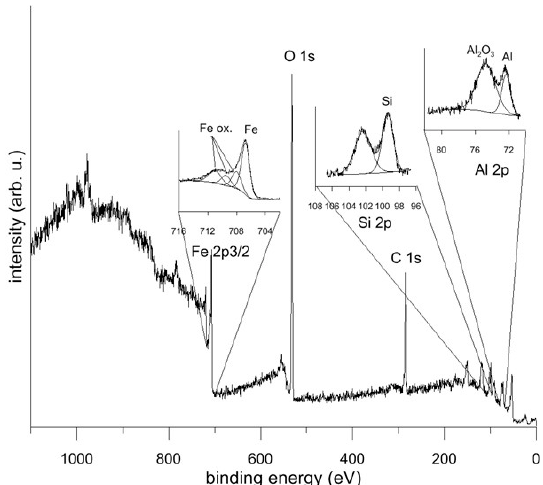
Figure 14. XPS spectrum of passivation layer on FeAl20Si20 formed in the electrolyte of pH = 5.6.